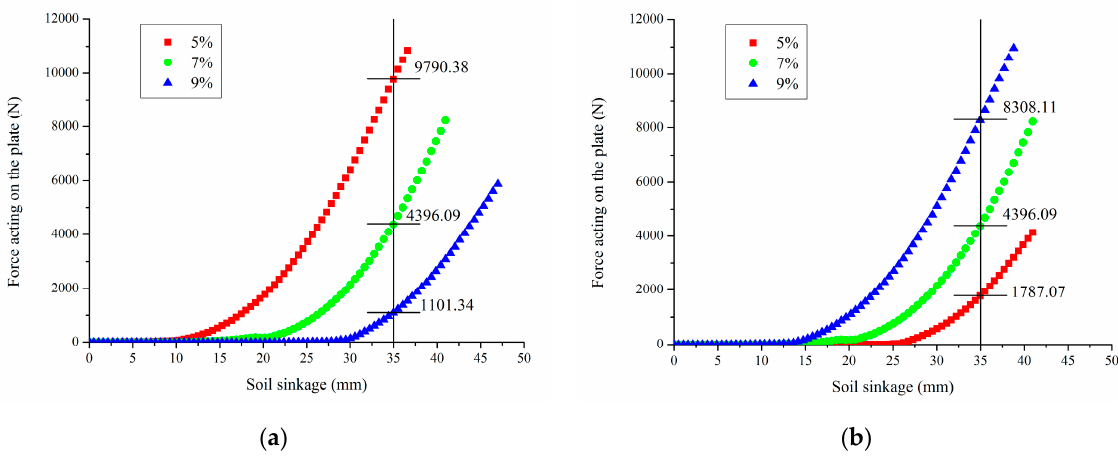
Figure 5. Pressure-sinkage curves of soil under different soil water contents and densities. ( a ) Influence of soil water content on curve when bulk density is 2 mg·m − 3 ; ( b ) Influence of bulk density on curve when soil water content is 7%.